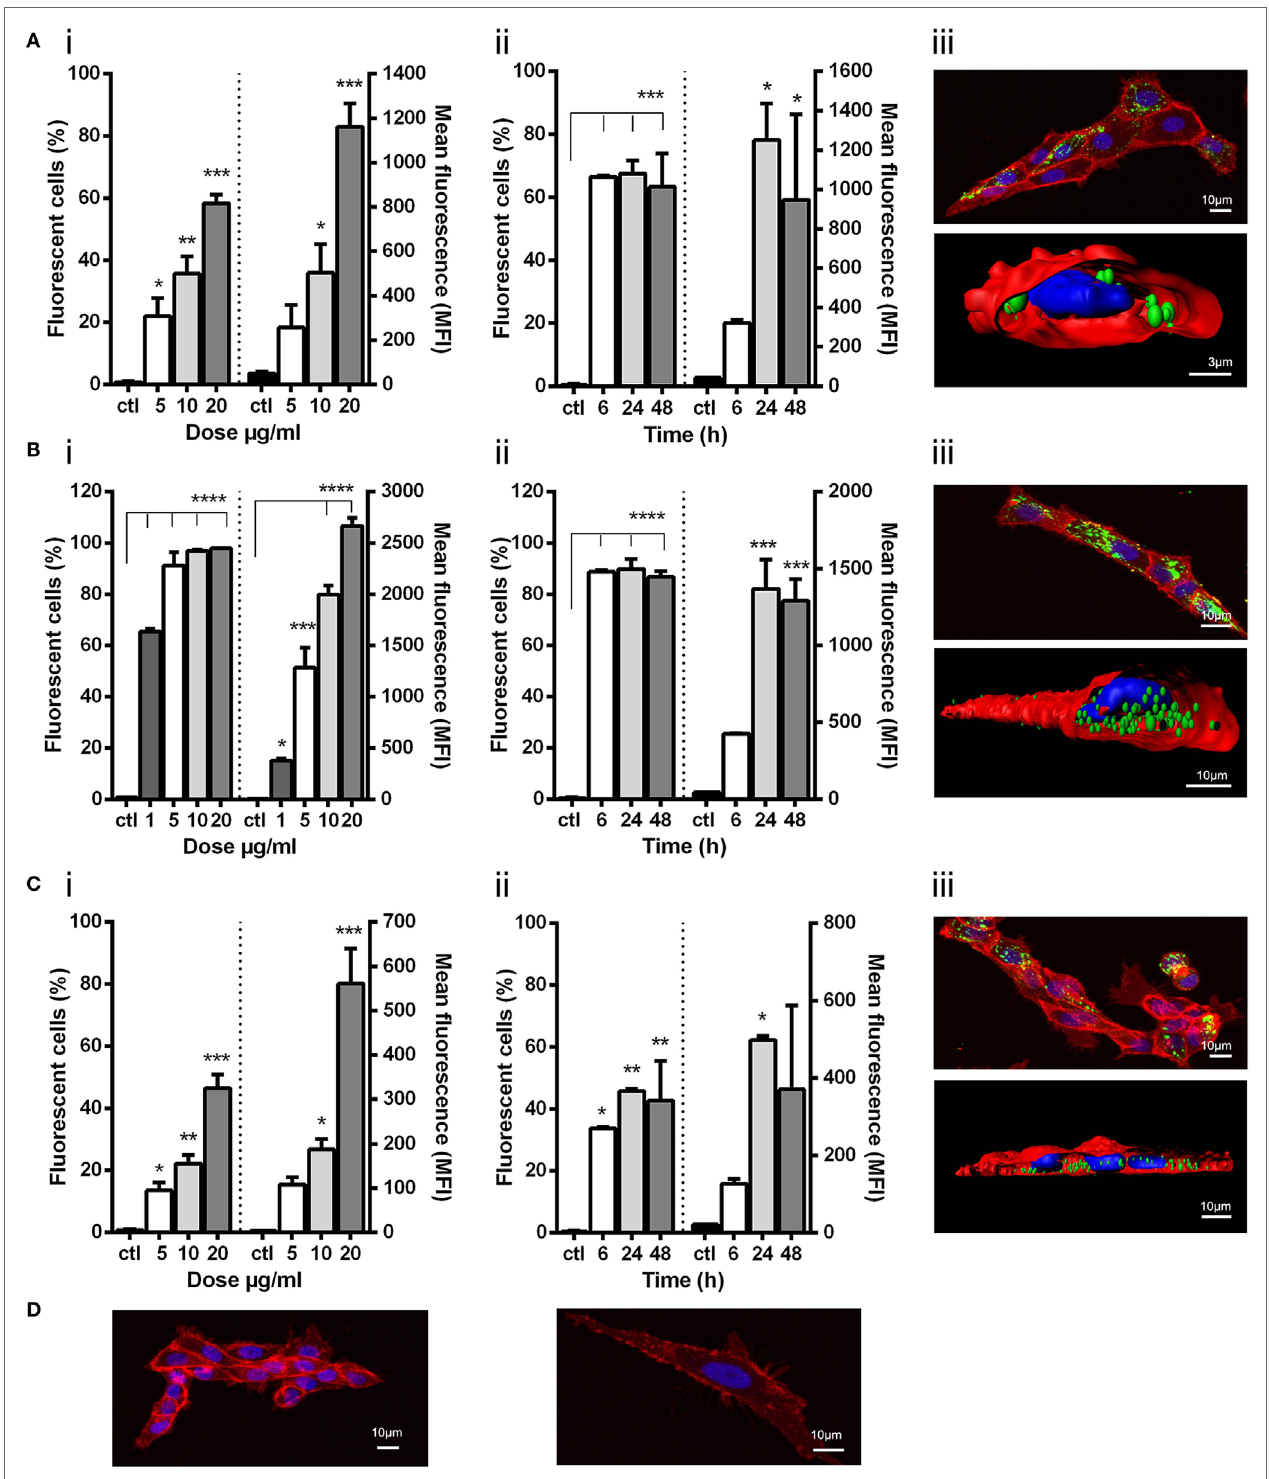
FigUre 2 | Uptake of viral nanopellets (NPs) by ZFL. Fluorescently labeled NPs (a) IPNV-VP2 NP , (B) VHSV-G-frg16 NP , and (c) VNNV-C NP were added to ZFL. Control (ctl) was ZFL without NPs. (i) Dose–response. Cells incubated for 12 h with NPs (a,c) at 5–20 µg/ml, and (B) at 1–20 µg/ml in duplicate. (ii) Time course. NPs added to cells at 10 µg/ml (a,c) , and 5 µg/ml (B) in duplicate and incubated for 6–48 h. Differences between means were analyzed by a one-way ANOVA with Dunnett’s multiple comparisons test, treatments versus control. Significance levels * p < 0.05; ** p < 0.01; *** p < 0.001; **** p < 0.0001. (iii) Confocal microscopy and digitalized image (z-stacks) of ZFL cells after 14 h incubation with 20 µg/ml (a,c) and 10 µg/ml (B) . NPs are green, cell membrane red, and nuclei blue. Control confocal image ZFL without NPs (D)